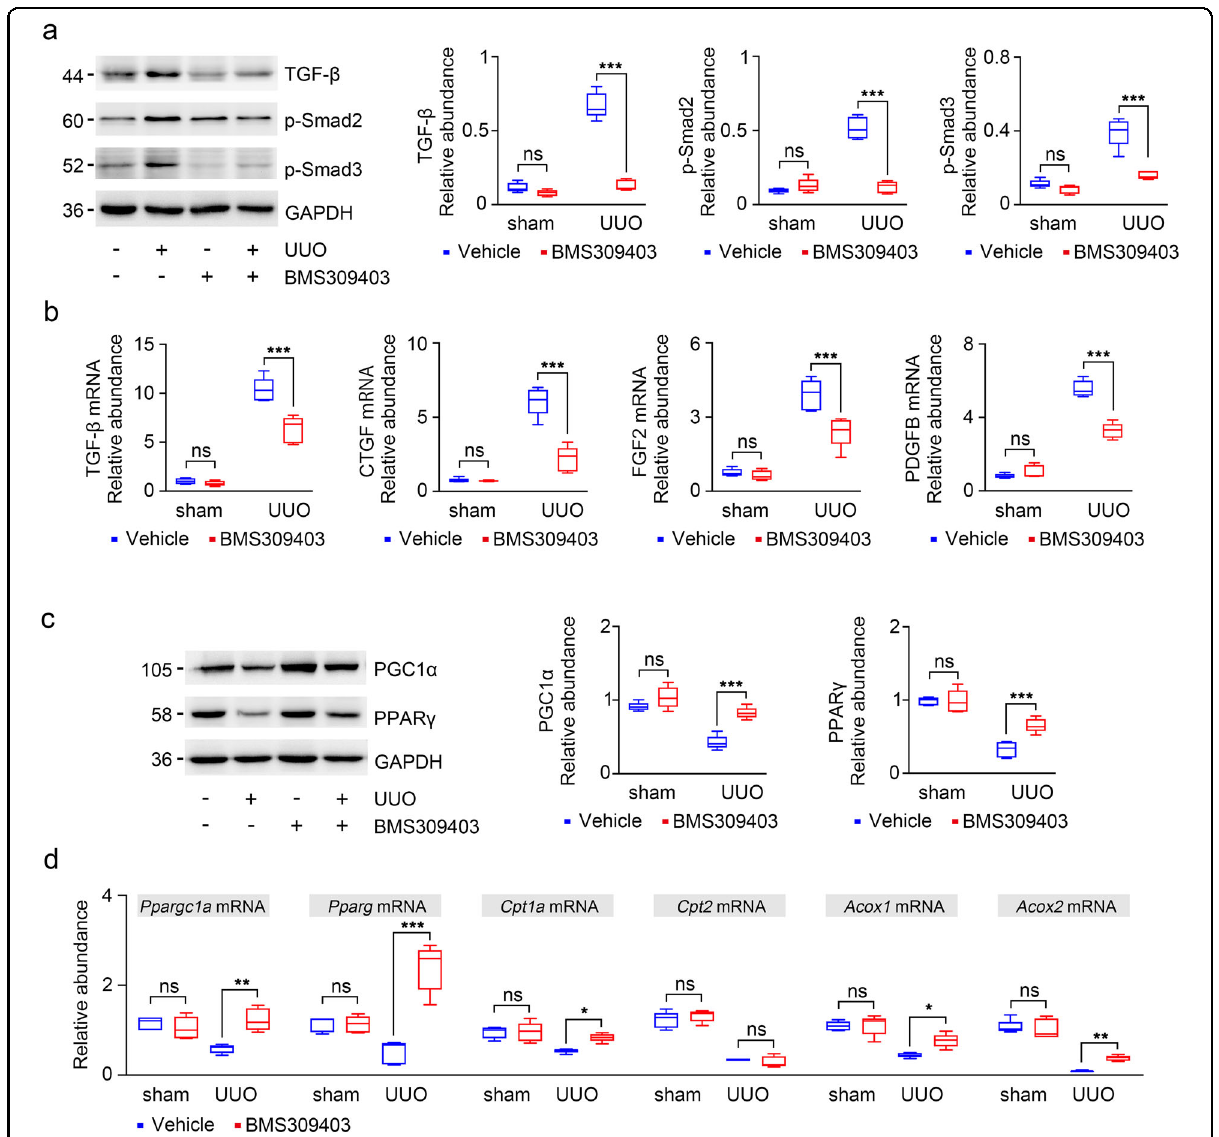
GAPDH. b RT-qPCR for TGF- β , CTGF, PDGFB, and FGF2 transcripts normalized to Gapdh in kidney tissue. c The changes in PGC1 α and PPAR γ expression levels were con fi rmed in mouse kidneys by immunoblotting studies. d Ppargc1a, Pparg, Cpt1a, Cpt2, Acox1, and Acox2 mRNA expression were analyzed by RT-qPCR in total RNA extracts of kidneys from saline- or BMS309403-treated normal and UUO mice. The transcript normalized to Gapdh. Representative images from three independent experiments are shown above. * P < 0.05, ** P < 0.01, *** P < 0.001, ns means no statistical signi fi